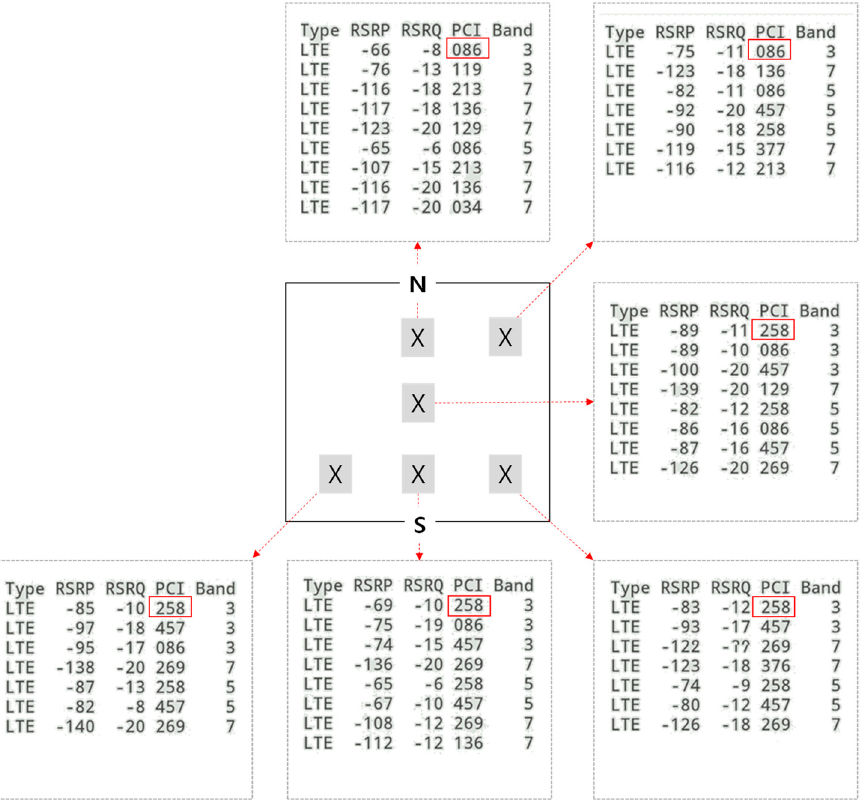
Figure 10. Physical cell IDs (PCI) of neighboring base stations with the strongest signal (measured at author’s house).